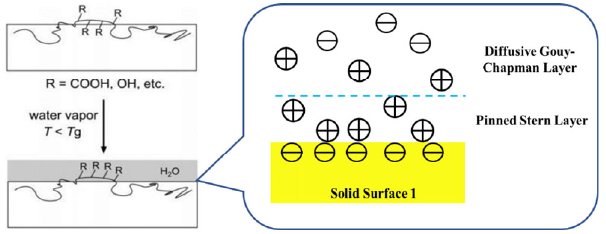
Fig. 10 The schematic illustration about the influence of humidity onto organic insulator surface during triboelectric process [2,